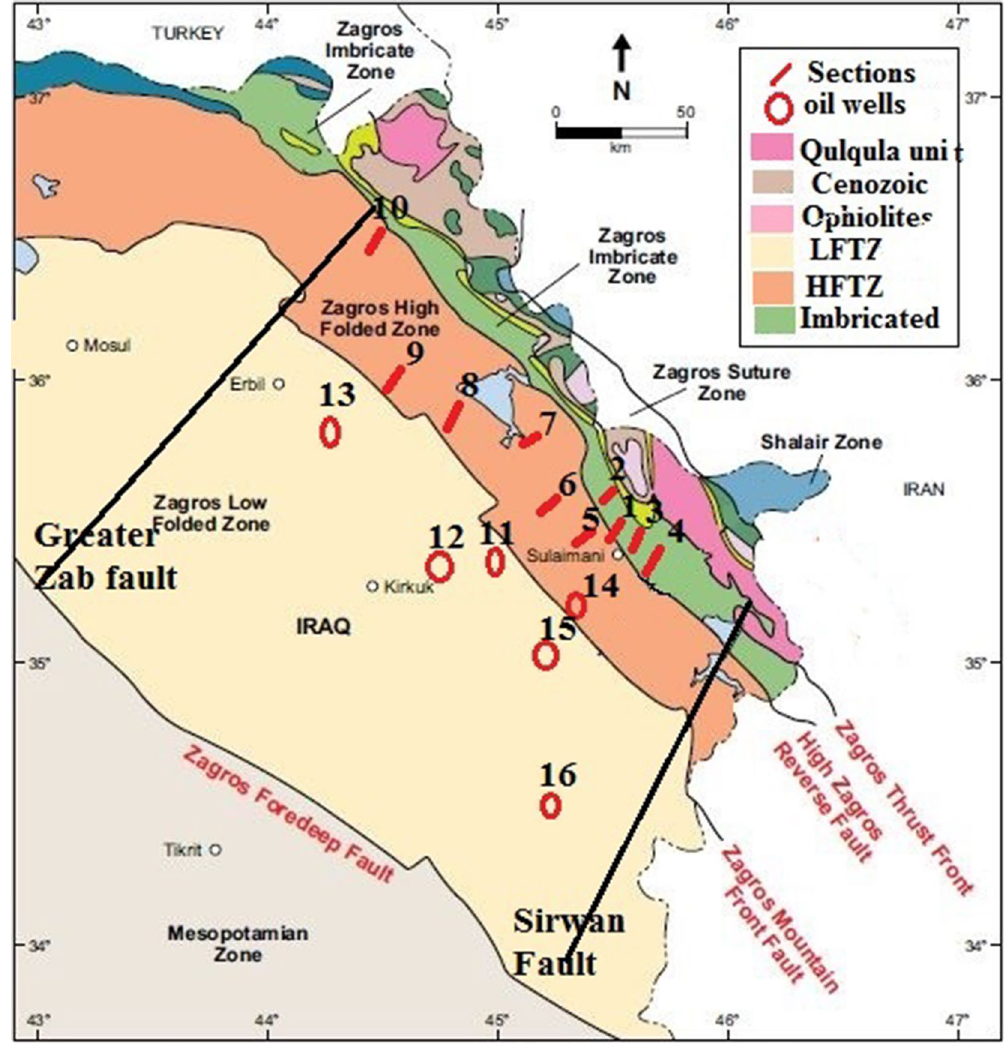
Fig. 1 Location map of the studied sections (1-Qaywan, 2-Konamassy, 3-Bazageer, 4-Alasiaw, 5-Mirgapan, 6-Zeywey, 7-Qarasirt,